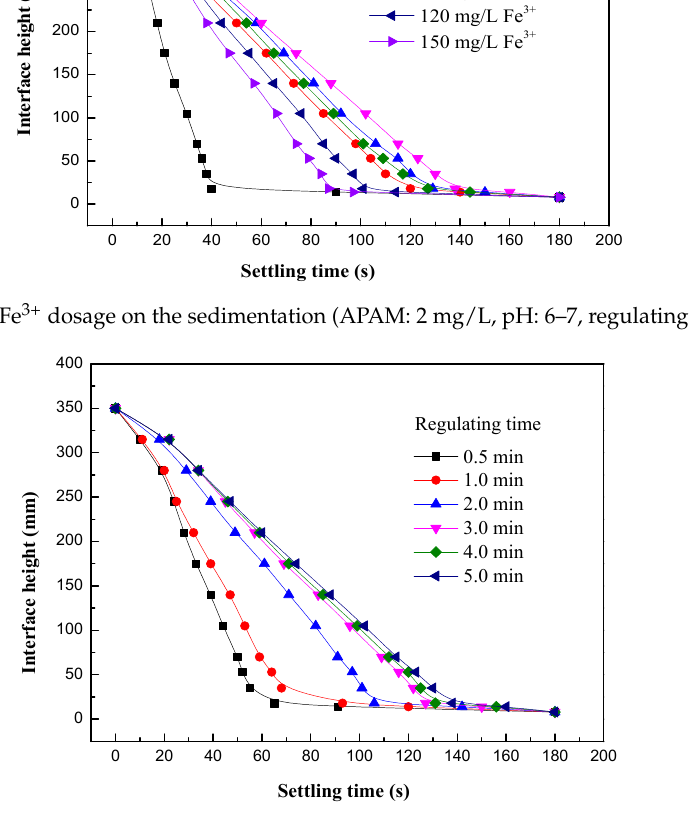
Figure 2. Effect of Fe 3+ regulating time on the sedimentation (APAM: 2 mg/L, pH: 6.4, Fe 3+ : 56 mg/L).